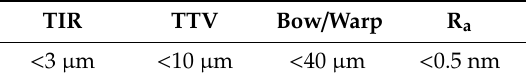
Table 1. Mechanical properties of silicon